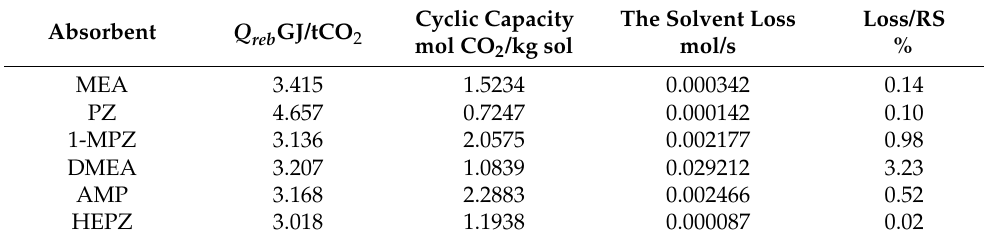
Table 3. Regeneration energy, solvent loss and cyclic capacity of different